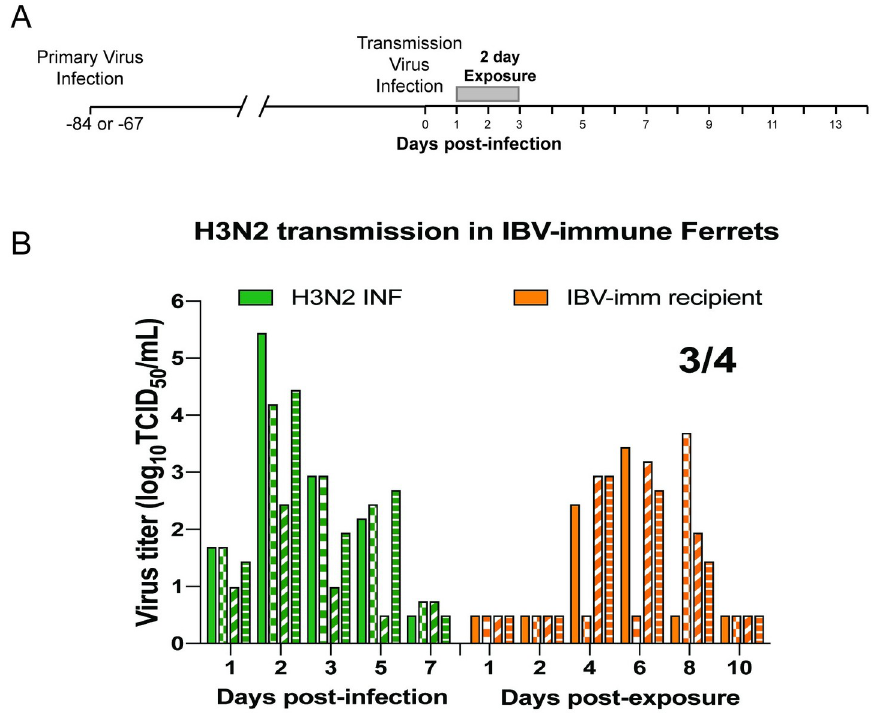
Fig 4. Innate immunity does not block H3N2 transmission. (A) Schematic of experimental procedure, gray bars depict 2-day exposure time. (B) Recipient animals were infected with B/Brisbane/60/2008 (IBV) virus 67 days prior to H3N2 (A/Perth/16/2009) transmission. Donor animals are denoted as H3 INF, and recipient animals are ‘IBV-imm’. Each bar represents an individual animal. Limit of detection is denoted by a dashed line.